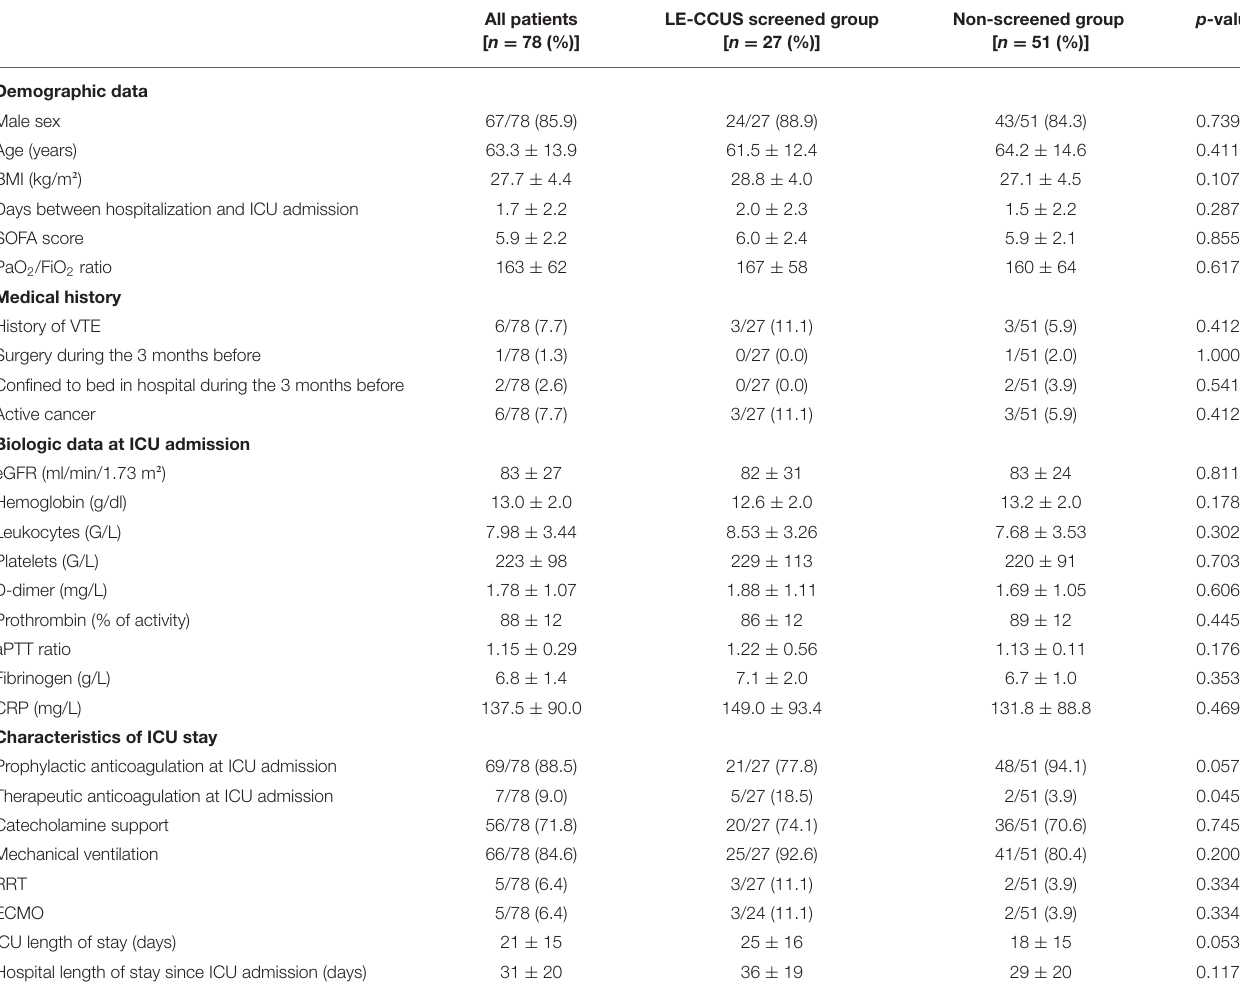
TABLE 1 | Characteristics of patients in ICU according to systematic screening or not for LE-DVT.